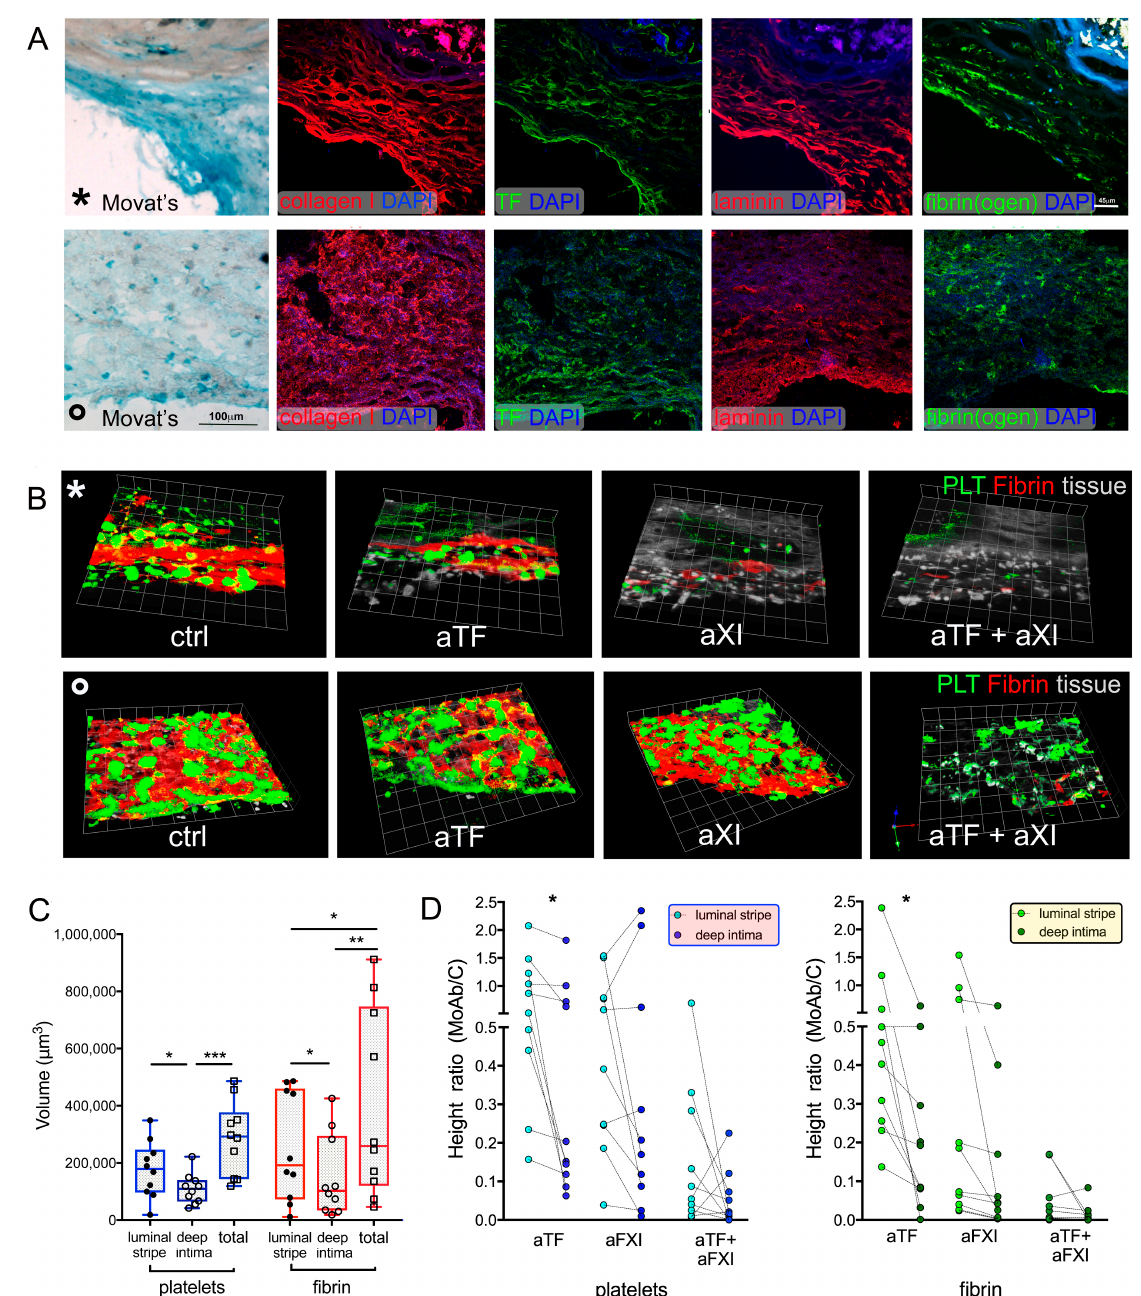
Figure 4. Influence of coagulation pathway blockades on thrombus formation over portions of CPL intima. Histology and distribution of immunolabelled molecules important for thrombus formation are presented (same fields of serial sections; symbols *, ◦ indicate the correspondence) ( A ). Three-dimensional renderings from confocal Z sections with colorized platelets and fibrin ( B ) show the global spatial changes in thrombus formation over intima in the presence of aTF and/or aFXI into blood in two selected fields from two CPL. Quantitative analysis of thrombus formation over intima of 5 CPL perfused with control blood ( C ) and with blood added with aTF and/or aFXI ( D ) shows differences between the sub-endothelial (luminal stripe, 70 μ m thick) and the deeper portions (deep intima) in platelet aggregation and fibrin strand deposition. Data from 10 fields are presented as boxes (5–95 percentile) with dots indicating the thrombus volume ( C ) or as before–after dot plot with dotted lines connecting luminal stripe and deep intima of the same field ( D ). Paired t -test was applied. Significant differences: * p < 0.05, ** p < 0.01. To evaluate the influence of morphology on thrombogenicity, the intima fields were divided into 2 subfields: the luminal stripe (sub-endothelial region, 70–75 μ m thick [37]), and the deep intima (underlying area).